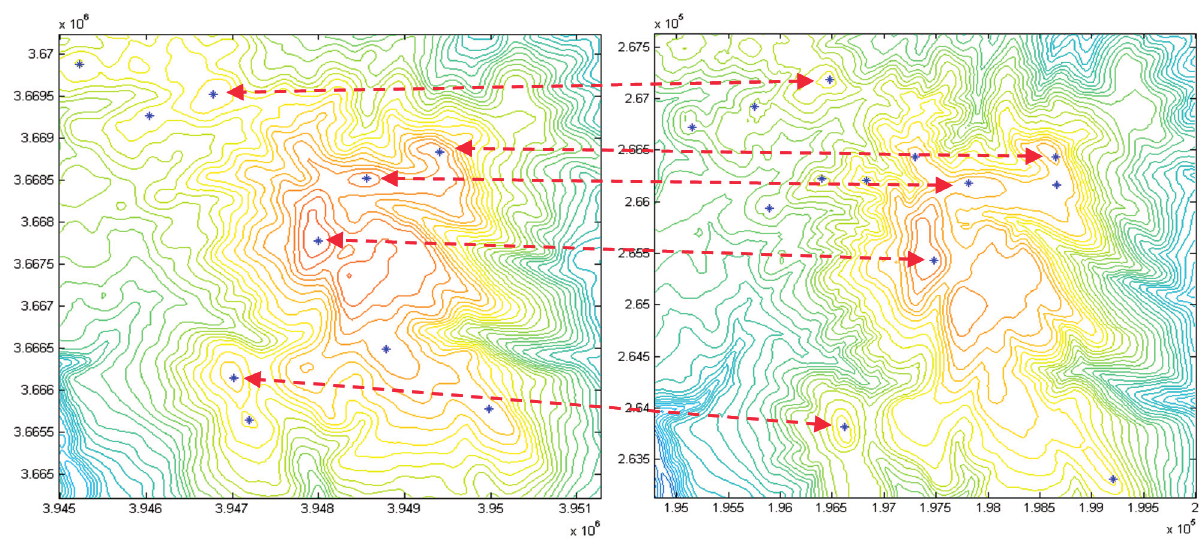
Figure 10. Height contour representation of the topography superimposed with the interest points identified for each database; corresponding interest points are shown.